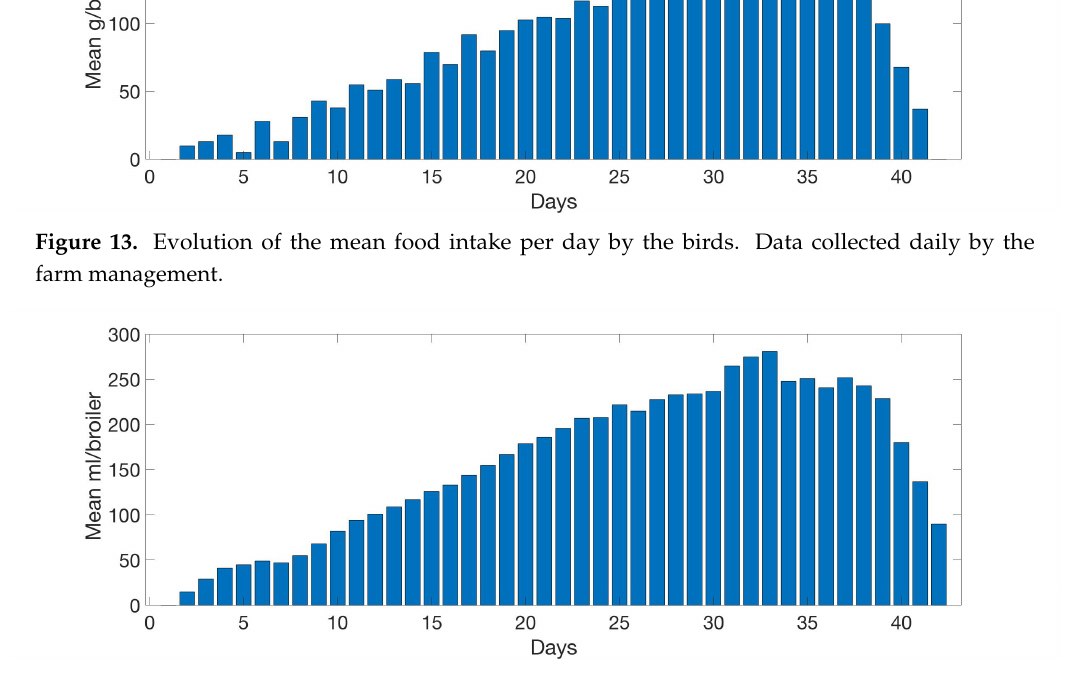
Figure 14. Evolution of the mean water intake per day by the birds. Data collected daily by the farm